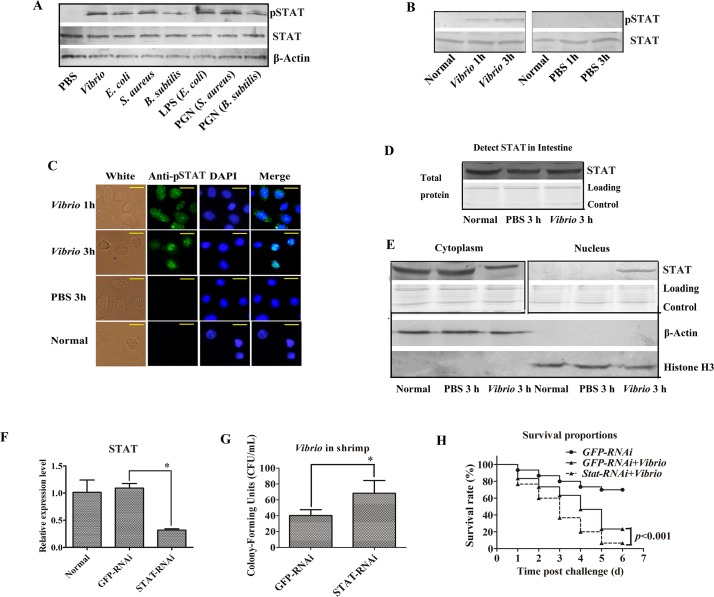
The JAK/STAT pathway plays an important role in shrimp antibacterial immunity.(A) Seven groups of shrimp were challenged with V. anguillarum, E. coli, S. aureus, B. subtilis, LPS from E. coli, PGN from S. aureus or B. subtilis and PBS, intestine proteins were extracted at 3 h, and STAT phosphorylation was analyzed by western blotting using a pSTAT antibody; total STAT and β-actin were detected with the corresponding antibodies (STAT or β-actin antibody) and were used as controls. (B) Detection of STAT phosphorylation in the intestine of shrimp 1 and 3 h after V. anguillarum challenge. PBS injection was used as a control. (C) STAT translocation in hemocytes was detected using an immunocytochemical assay with the pSTAT antibody. The PBS-injected shrimp and untreated shrimp were used as controls. (D) Total protein or the cytoplasmic or nuclear proteins were extracted from the intestine of shrimp challenged with V. anguillarum and used for western blot analysis with a STAT antibody. (E) The subcellular distribution of STAT in the intestine was detected by western blotting. β-actin antibody and histone H3 antibody were used as loading controls for the cytoplasmic or nuclear proteins. PBS injection was used as the control. (F) The efficiency of STAT-RNAi was analyzed by qRT-PCR. (G) The bacterial scavenging capacity of the shrimp after STAT-RNAi. dsGFP injection was used as the control. (H) The survival rate of STAT-RNAi shrimp infected with V. anguillarum. GFP-RNAi was used as the control. Differences among the groups were analyzed using a t-test (*p < 0.05).